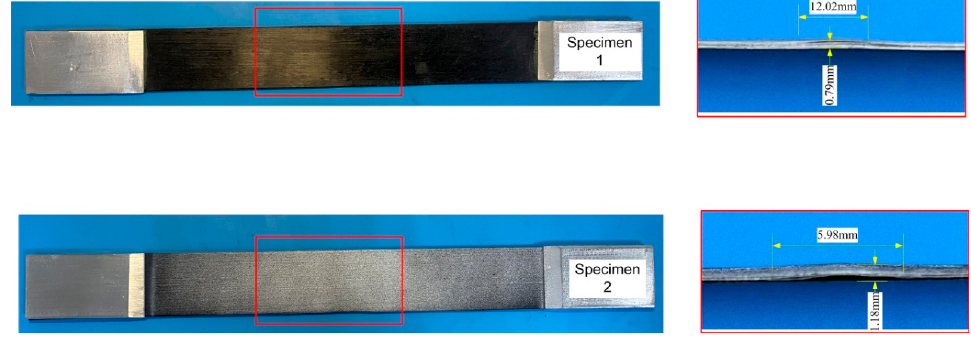
Figure 10. Morphology of wrinkles. The geometric parameters of the wrinkles are listed in Table 2. Table 2. Geometric parameters of wrinkle defects.